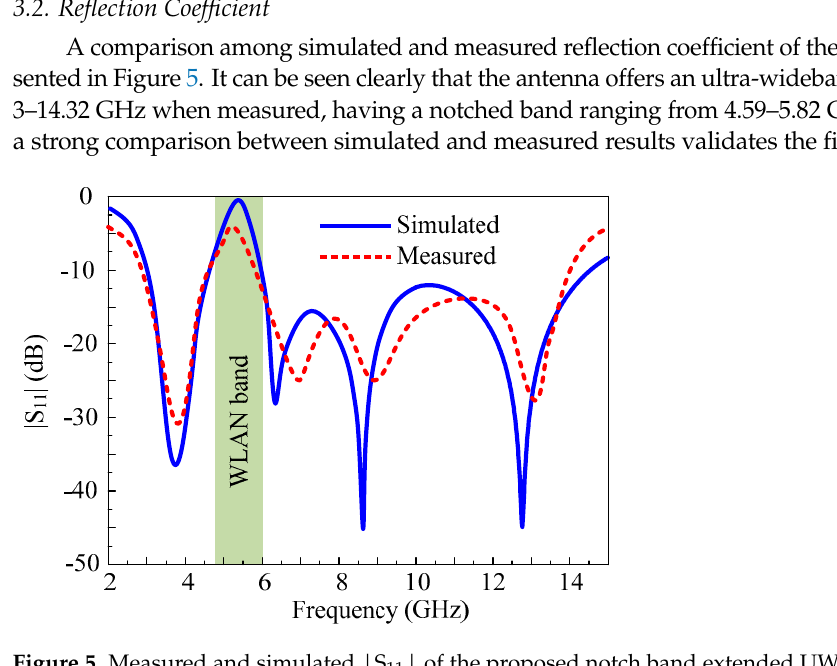
Figure 5. Measured and simulated |S 11 | of the proposed notch band extended UWB antenna.